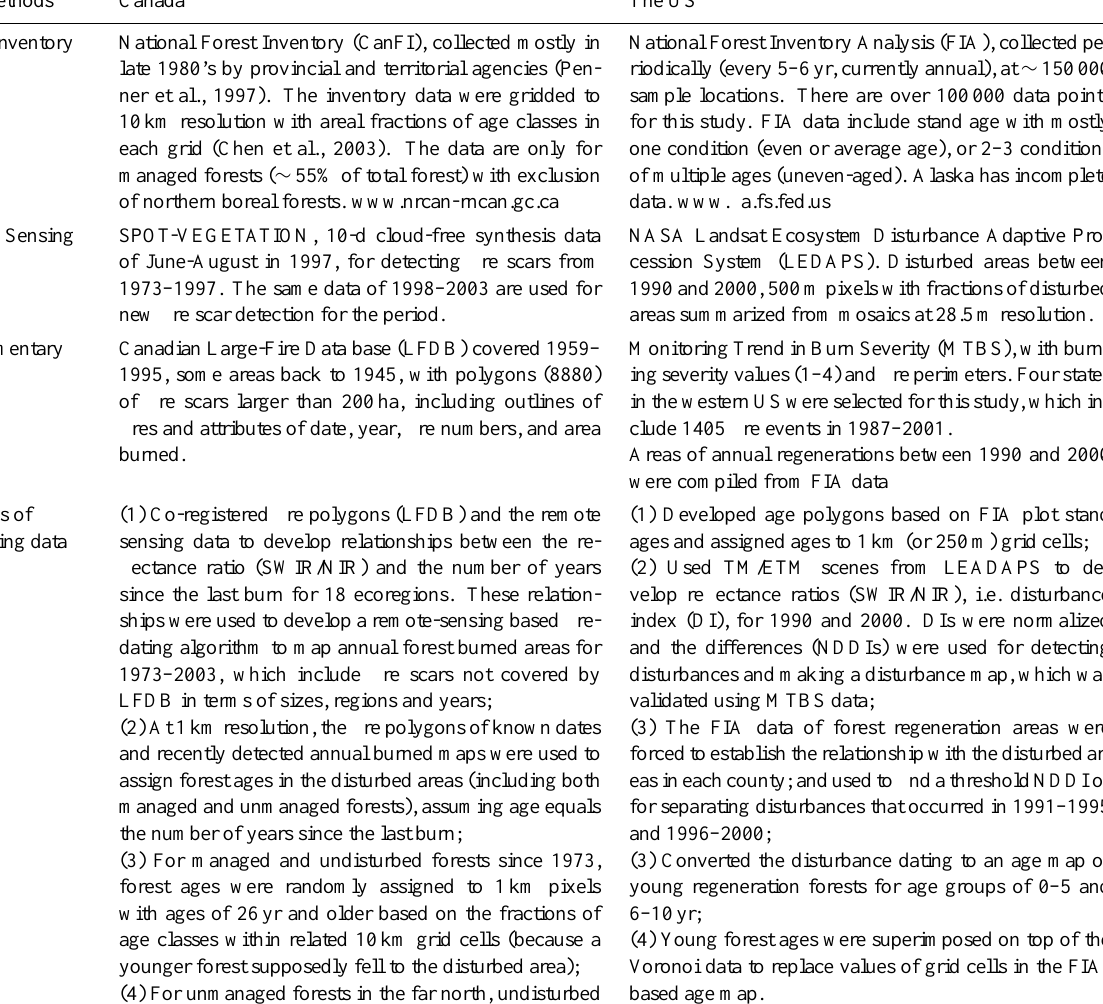
Table 1. Comparison of data and methods used to develop forest age maps for Canada and the US.